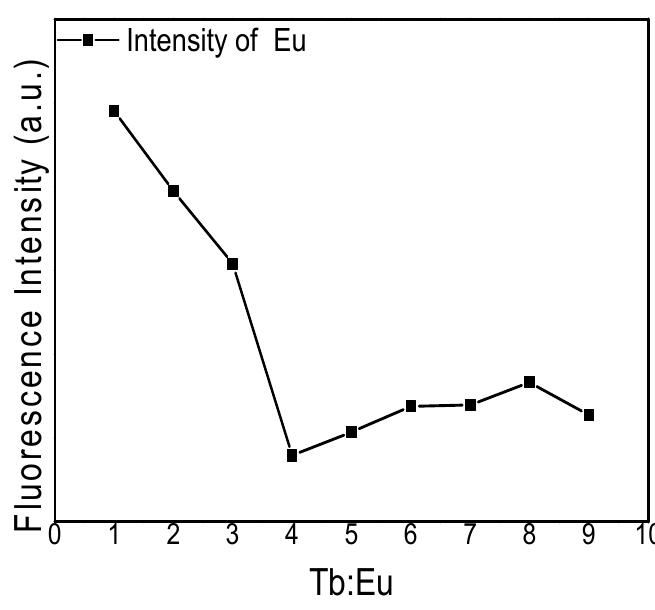
10 of 13 Figure 8. Fluorescence emission intensity of PVA fluorescent gel of ( a ) Eu and ( b ) Tb at different reaction temperatures. Figure 9 presents the fluorescence emission intensity of the PVA fluorescent gel with different Eu 3+ :Tb 3+ ratios by controlling the reaction time and reaction concentration. It is shown that the fluorescence intensity of Eu 3+ first decreased and then increased with the addition of Tb 3+ when the water content remained unchanged. It can be inferred that Tb 3+ binds to ligands more easily when the Tb3+:Eu3+ ratio is less than 4 (Eu 3+ needs four ligands and Tb 3+ only five); when the Tb 3+ :Eu 3+ ratio is greater than 4, the sensitization of water to salt is stronger, which leads to an increase in